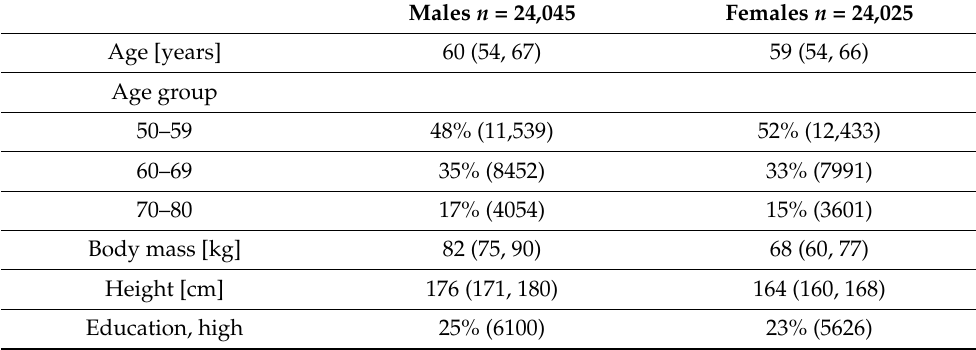
Table 1. Baseline